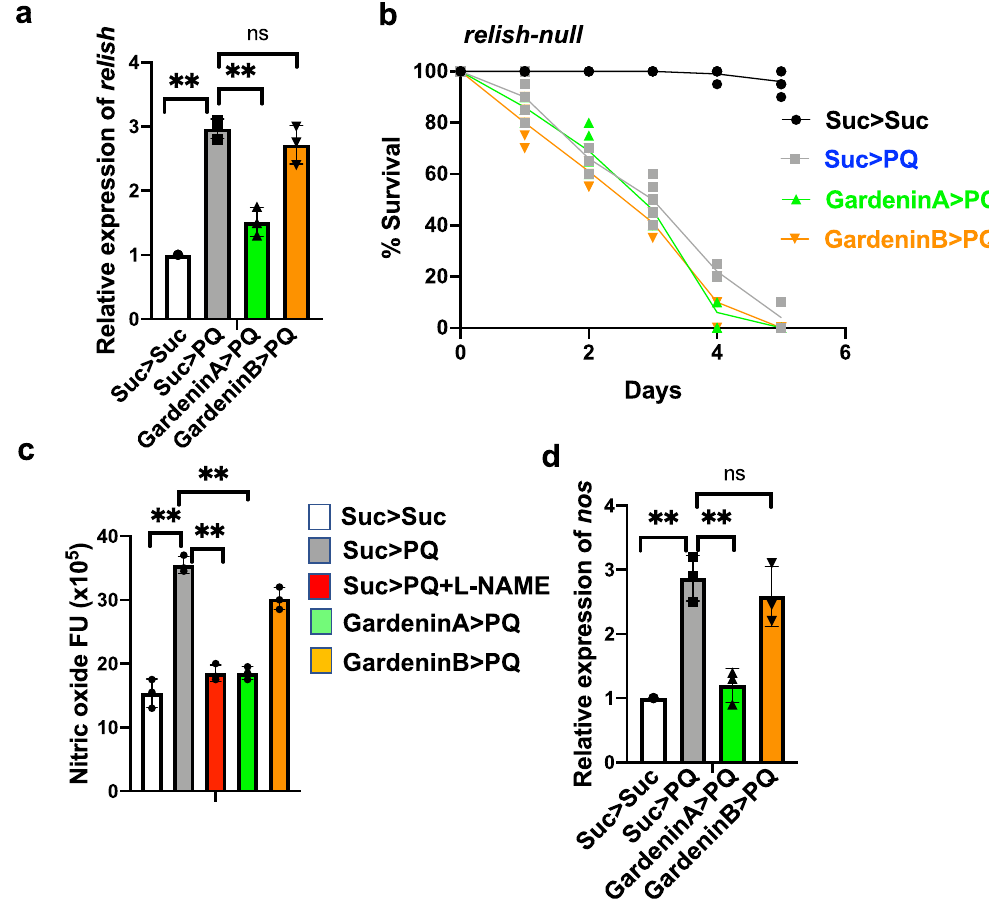
Fig. 4 GardeninA confers protection against PQ-induced neurotoxicity through modulation of the neuroin fl ammatory responses in Drosophila . a Effects of GA and GB on the transcript levels of relish , the human NF κ B orthologue in Drosophila using qRT-PCR. RNA was isolated from the heads of adult fl ies following exposure to the speci fi ed feeding conditions. The transcript levels of relish were analyzed and plotted after normalization with rp49 levels as the internal control. Each data point represents mean ± SEM. The mRNA fold changes are normalized to the sucrose-fed (Suc > Suc) fl ies (assigned a value of 1). ** p < 0.01 between different feeding conditions based on Mann – Whitney U test. b Survival assays were set up using adult relish-null mutant male fl ies following exposure to the indicated feeding conditions and the number of live fl ies was recorded every 24 h until all of the fl ies died, and the survival percentages were plotted. Data are representative of ten independent biological replicates with ten male fl ies per feeding conditions. Data shown represents mean ± SEM. c Effects of GA and GB on the levels of nitric oxide using fl uorometric assay. Adult male fl ies were either pre-fed for 4 days with 2.5% sucrose or GA or GB (10 μ M) followed by exposure to either sucrose or 5 mM PQ or PQ + L -NAME for 18 h (white bar: Suc>Suc, gray bar: Suc>PQ, red bar: Suc>PQ + L -NAME, green bar: GardeninA>PQ, orange bar: GardeninB>PQ). The fl y head homogenates were used to detect the nitrite levels. All experiments were performed in triplicate and represent at least three independent biological repeats. Data shown are expressed as fl uorescence arbitrary units (mean ± SEM). * p < 0.05; ** p < 0.01 based on one-way ANOVA between different feeding conditions. d Effects of GA and GB on the transcript levels of nitric oxide synthase ( nos) , the enzyme involved in the synthesis of nitric oxide in Drosophila using qRT-PCR. RNA was isolated from the heads of adult fl ies following exposure to the speci fi ed feeding conditions. The transcript levels of nos were analyzed and plotted after normalization with rp49 levels as the internal control. Each data point represents mean ± SEM. The mRNA fold changes are normalized to the sucrose-fed (Suc > Suc) fl ies (assigned a value of 1). ** p < 0.01 between different feeding conditions based on Mann – Whitney U